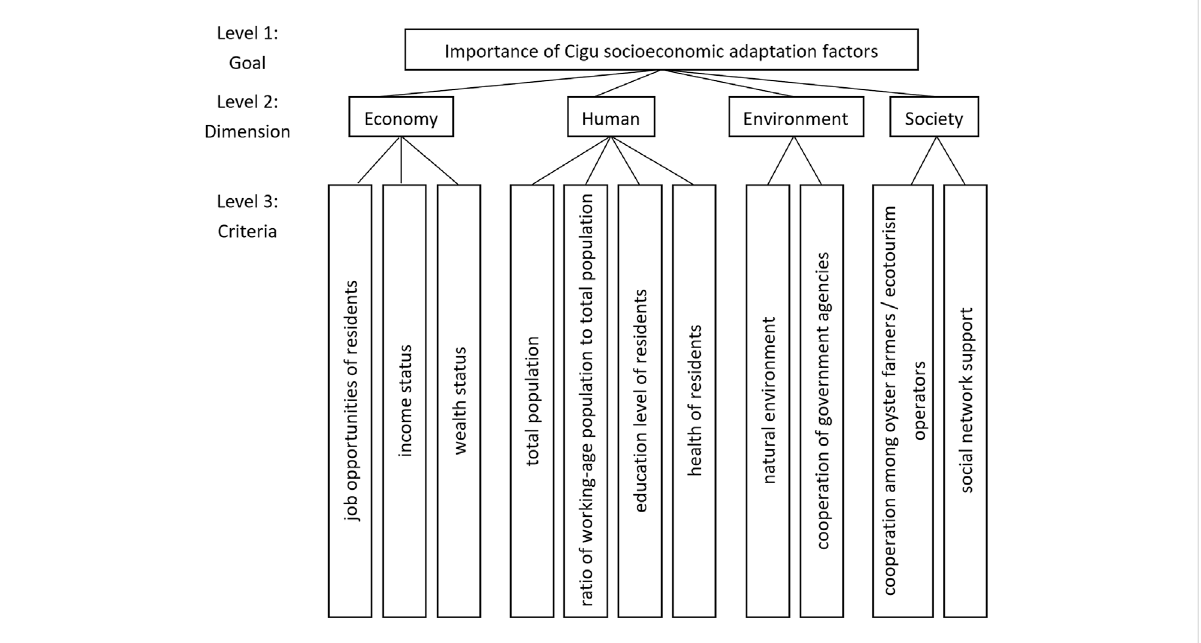
FIGURE 7 Hierarchy of factors for Cigu socioeconomic adaptation.